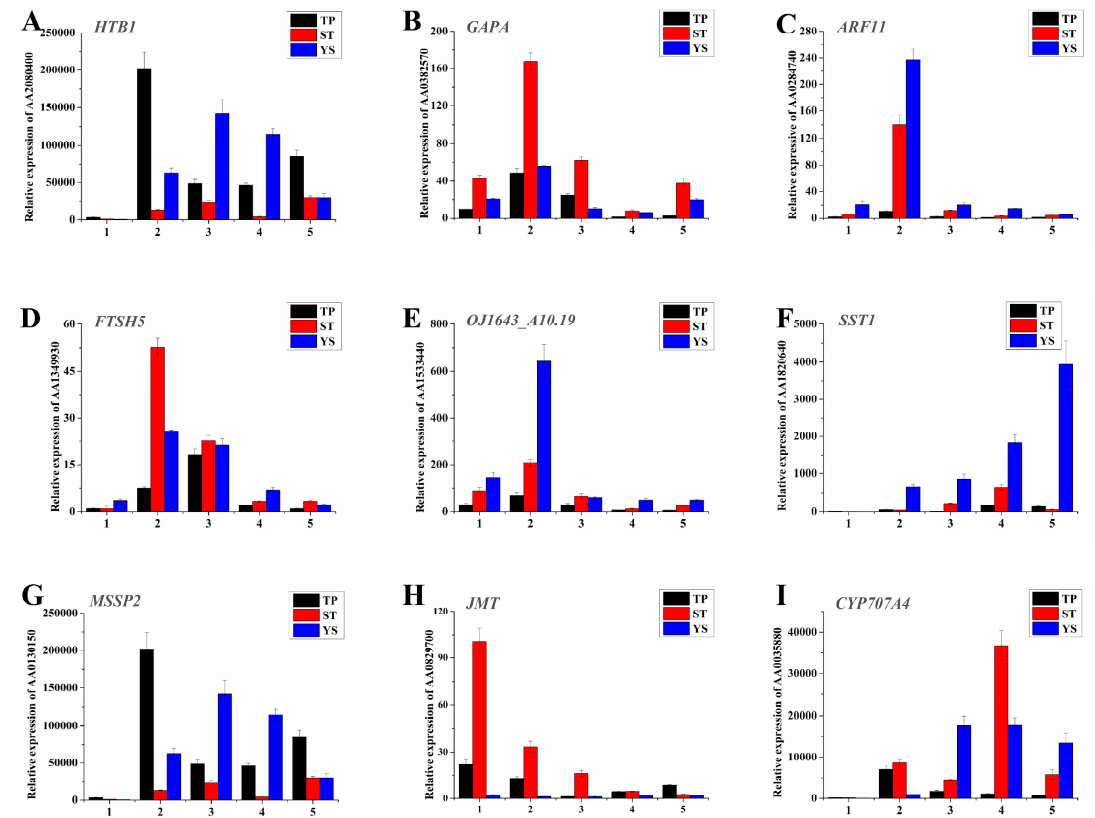
Figure 8. Spatiotemporal expression profiles of the nine DEGs in TPs (tiller primordia), STs (stem tips), and YSs (young spikes). ( A ) AA2080400 (Histone H2B.1); ( B ) AA0382570